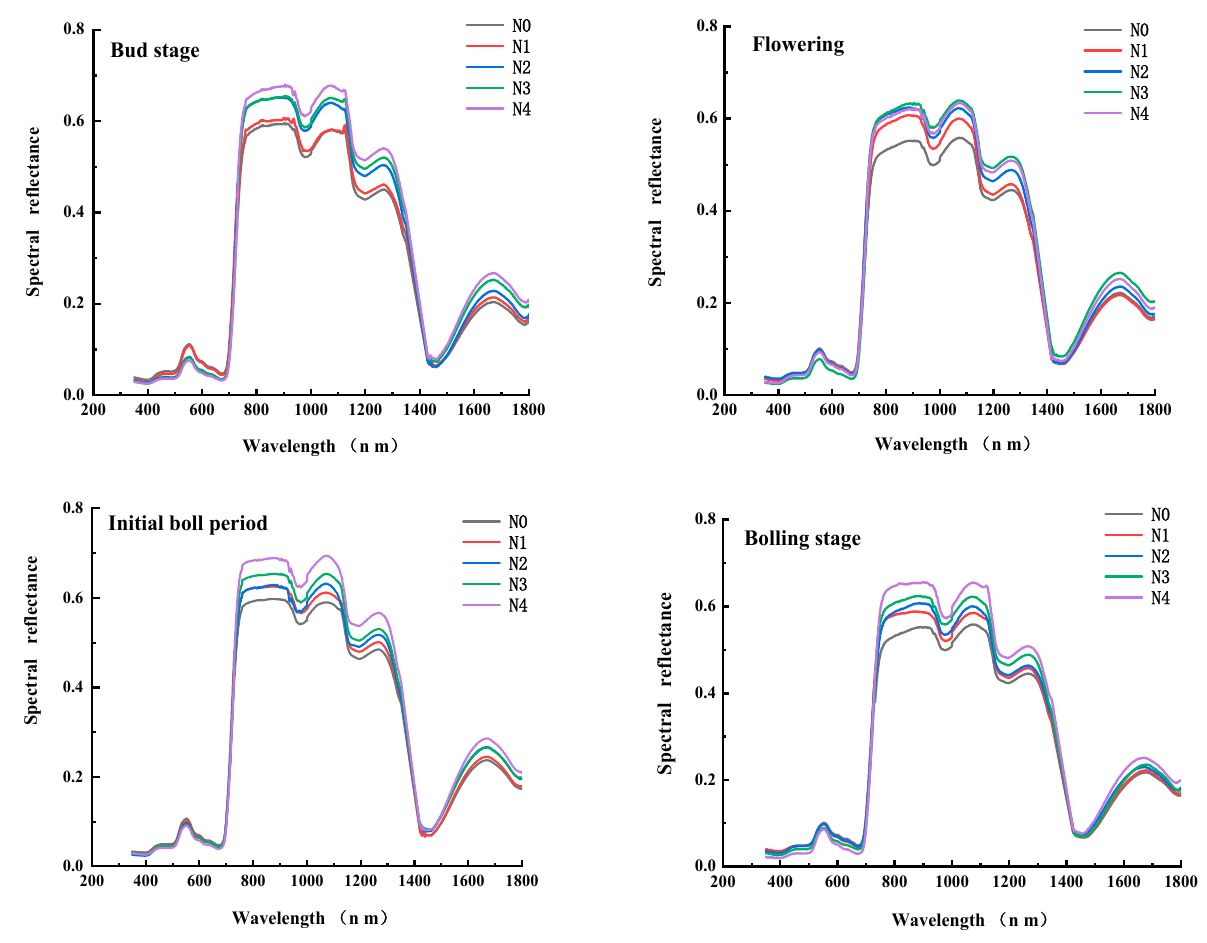
Figure 3. The spectral reflectance of the cotton canopy at different growth stages under varying nitrogen treatments.